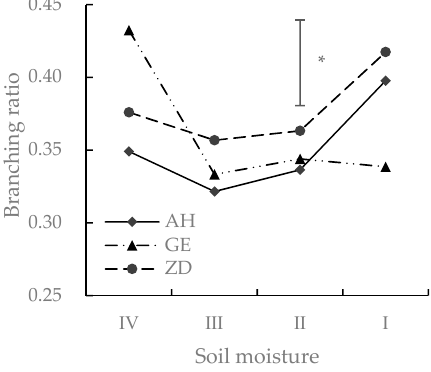
Figure 6. Interaction on branching ratio between cultivars (AH, GE and ZD) and soil moisture (See Figure 2 for soil moisture abbreviations). * p < 0.05. Table 5. Mean branching ratio (BR) under various soil moisture (See Table 1 for soil moisture